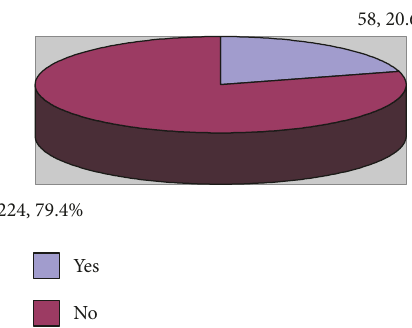
Figure 4: Prevalence of high depersonalization (cynicism) among emergency department physicians and nurses.